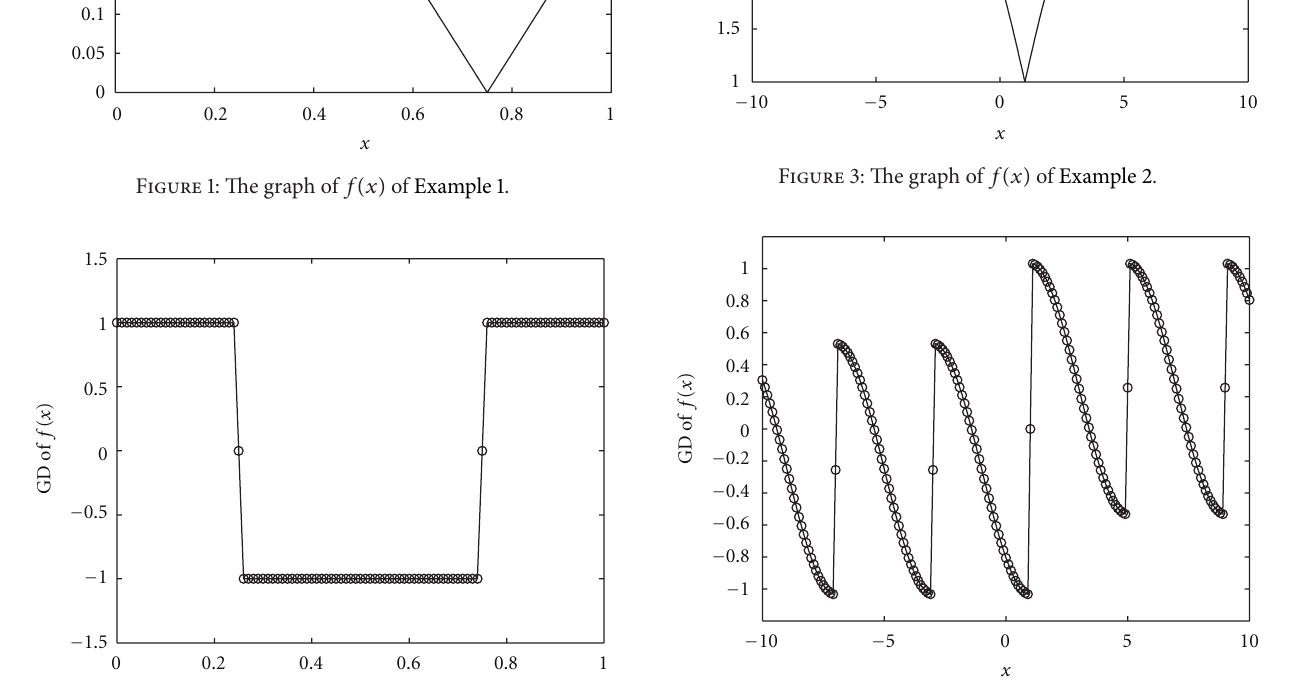
Figure 4: The graph of GD of Example